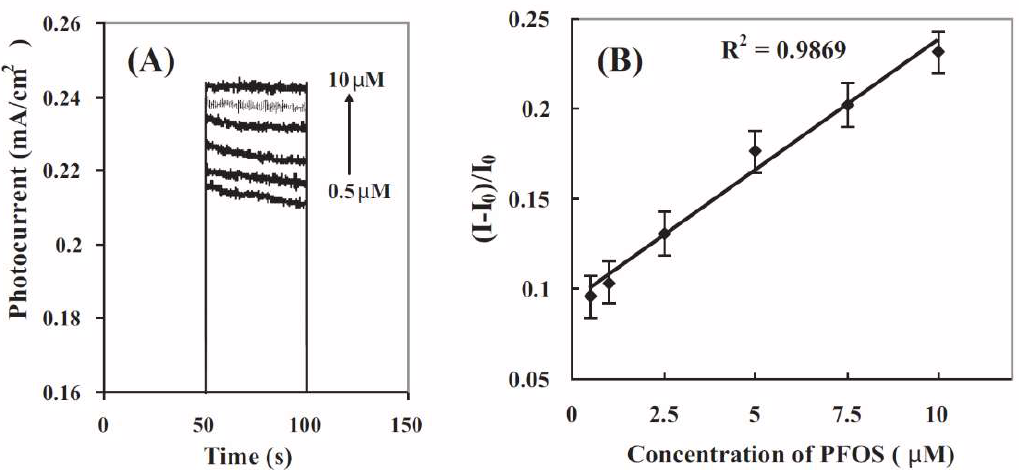
Figure 2. Photocurrent responses of ( A ) an MIP@TiO 2 nanotube arrays (NTA) electrode in 0.1 M PBS (pH 7) solution containing 0.5, 1, 2.5, 5, 7.5, and 10 µ M PFOS (from bottom to top). ( B ) Linear calibration curve. All photocurrents were recorded after the electrodes were immersed in the PFOS solution for 15 min. Reproduced with permission from Tran et al. [81] .